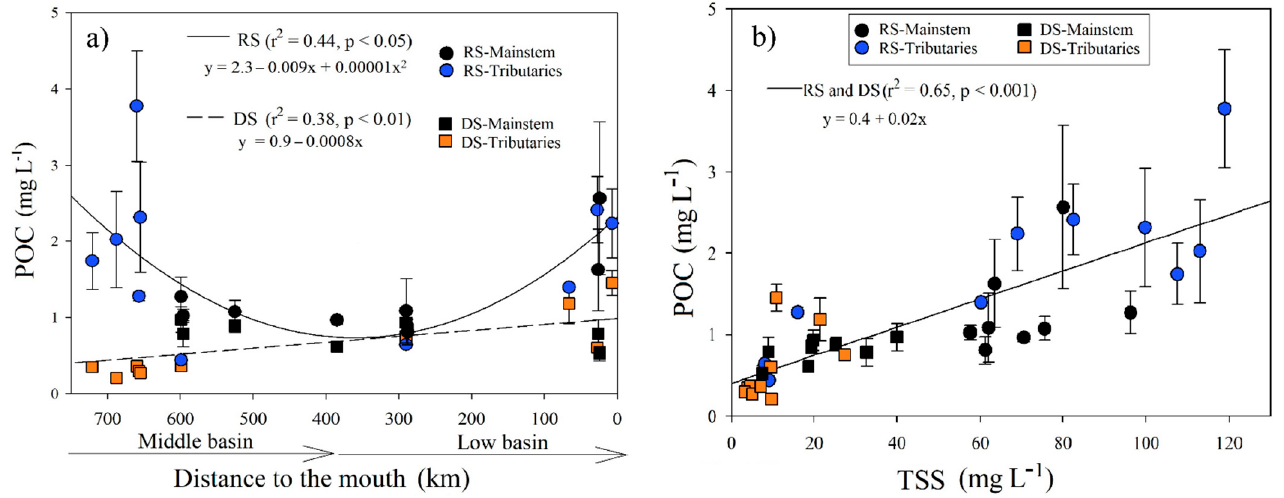
Figure 4. ( a ) Longitudinal variations in the POC concentration ( ± SD) according to distance to the Usumacinta River’s mouth during the rainy (RS) and dry (DS) seasons; ( b ) POC ( ± SD) adjustment regarding total suspended solids concentration in the Usumacinta River in the rainy (RS) and dry (DS) seasons. The mainstem differs in both seasons from the tributaries.